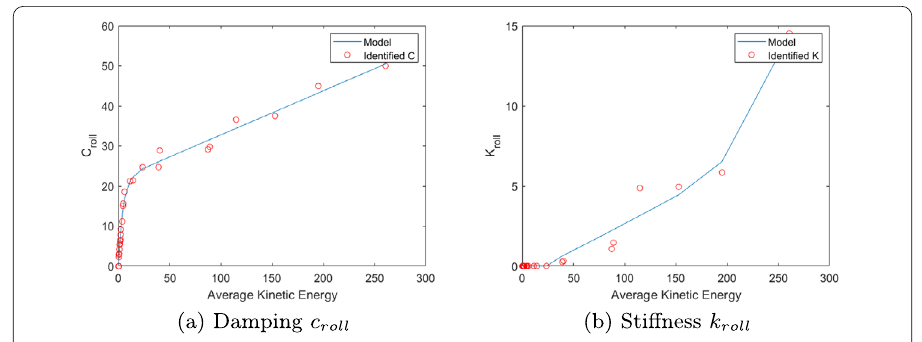
Figure 14 Damping and stiffness for the roll axis against the fitted model of Equations (79) and (80)